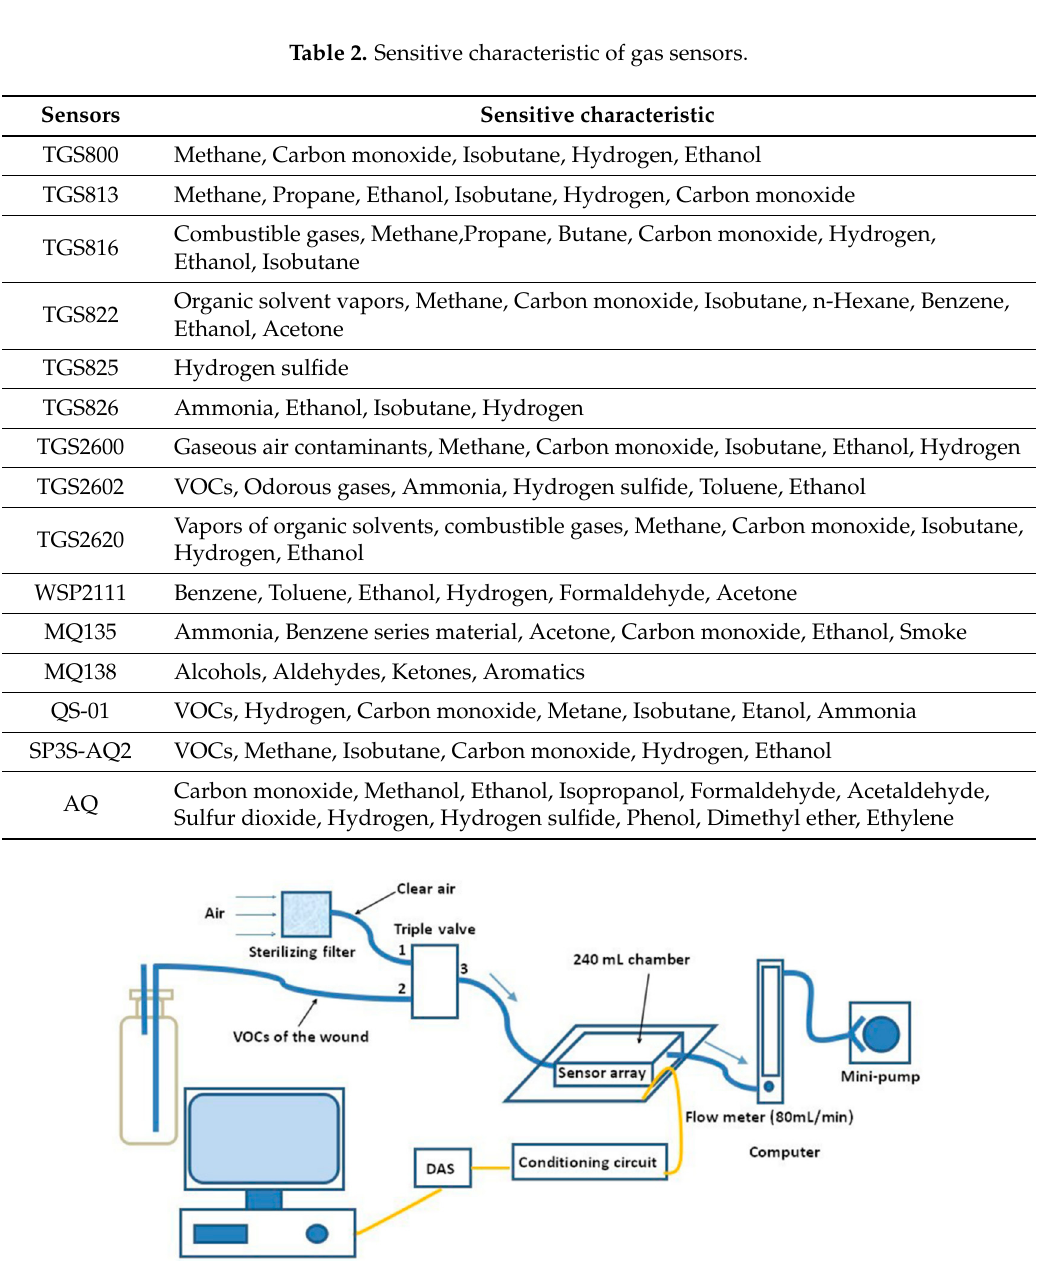
Table 2. Sensitive characteristic of gas sensors.